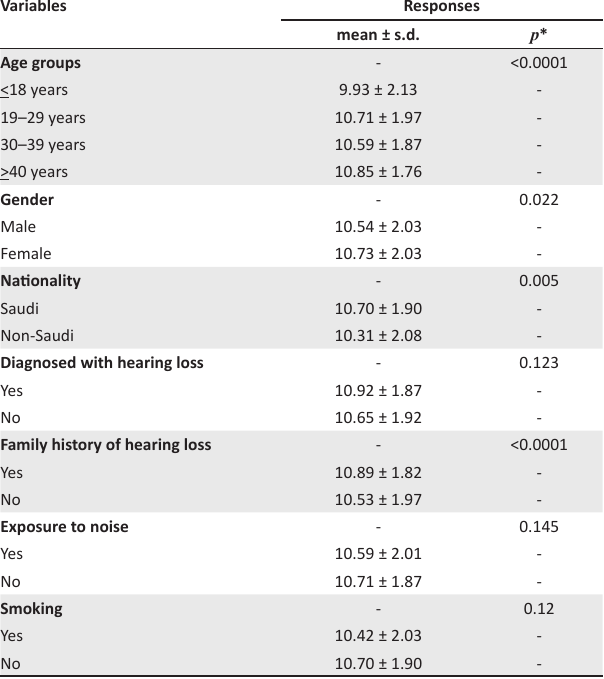
TABLE 4: The mean of correct responses to the true or false questionnaire among the sample ( n = 2372). Variables